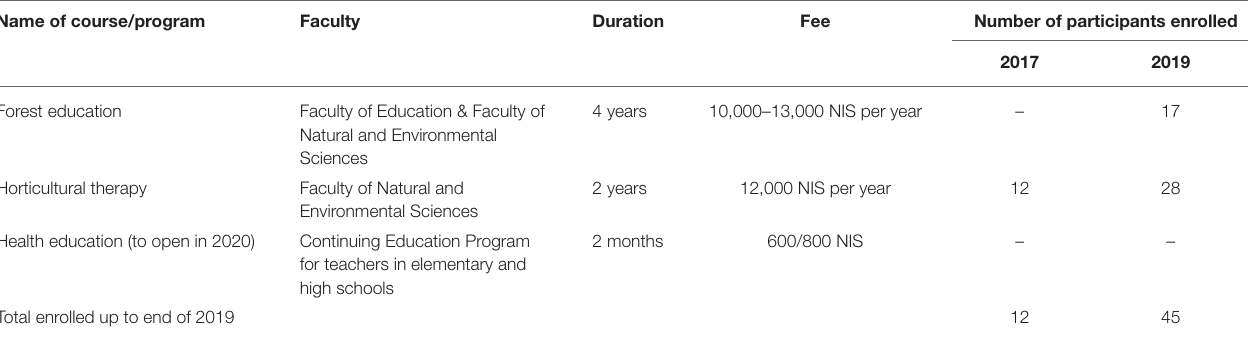
TABLE 6 | New community courses related to health promotion (course fees are a guide before deductions are included).